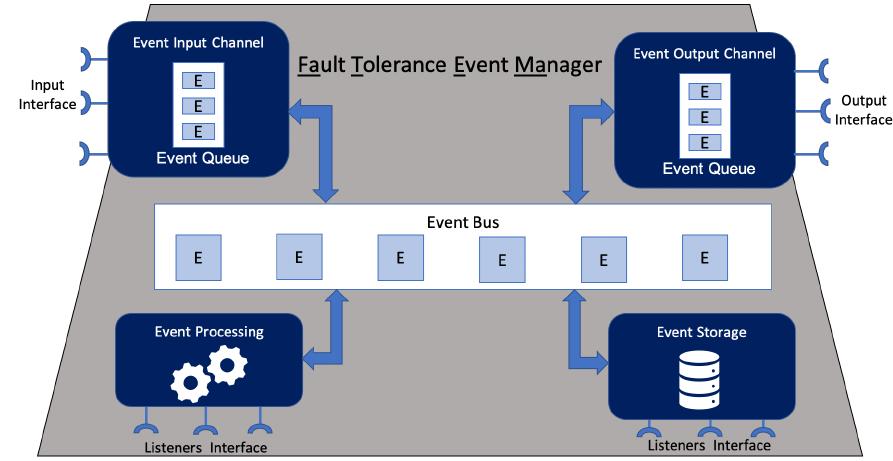
Figure 1. Fault Tolerance Event Manager (FaTEMA)